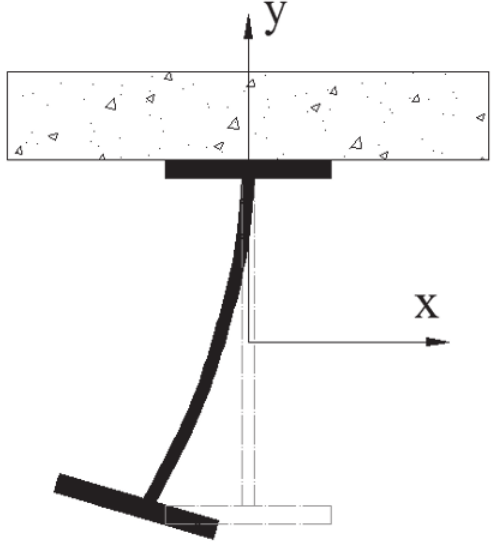
Flambagem lateral com distorção [3] Adaptada pelos